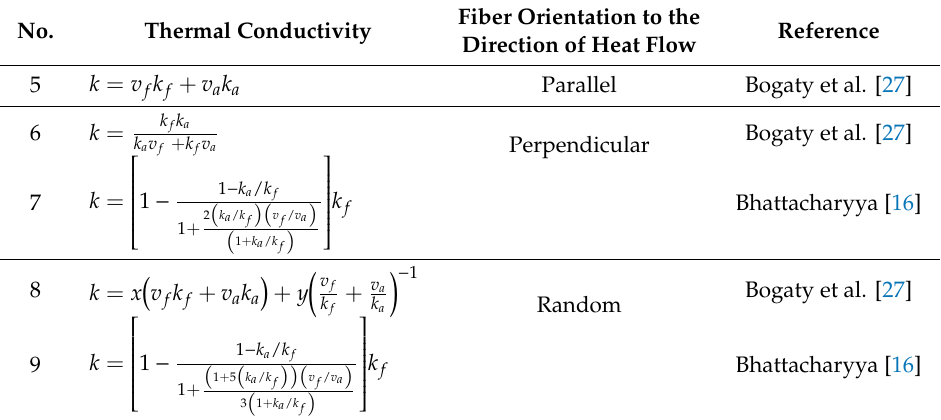
Table 2. Some models for fibrous material with parallel, perpendicular, and random fiber orientations.